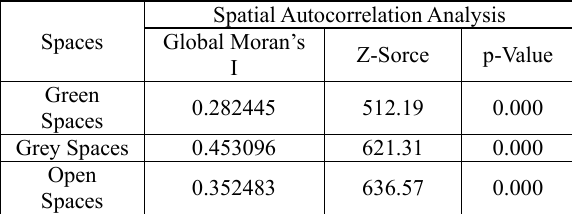
Tabel 3 . Statistic results of spatial global autocorrelation